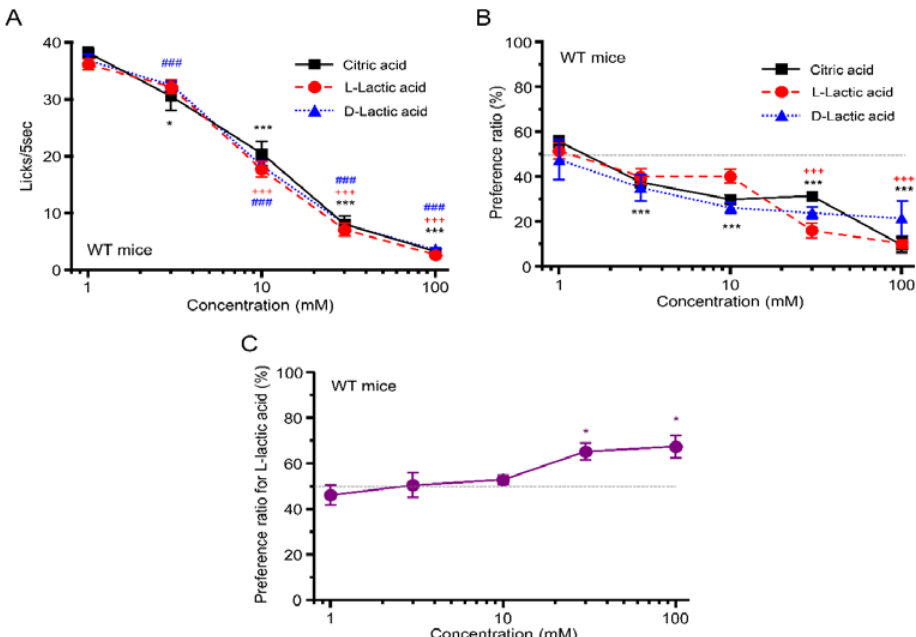
Figure 3. Behavioral responses to sour compounds in WT mice. ( A ) The number of licks of citric acid (black squares), L -lactic acid (red circles), and D -lactic acid (blue triangles) in the short-term (5 s) lick test ( n = 7). ( B ) Preference ratio for citric acid (black squares), L -lactic acid (red circles), and D -lactic acid (blue triangles) in the 48 h two-bottle test ( n = 6). ( C ) Preference ratio for L -lactic acid over D -lactic acid in the 48 h two-bottle test ( n = 6). * p < 0.05, *** p < 0.001, +++ p < 0.001, ### p < 0.001, post hoc Tukey HSD test (vs. 1 mM). All data are presented as the mean ± standard error.